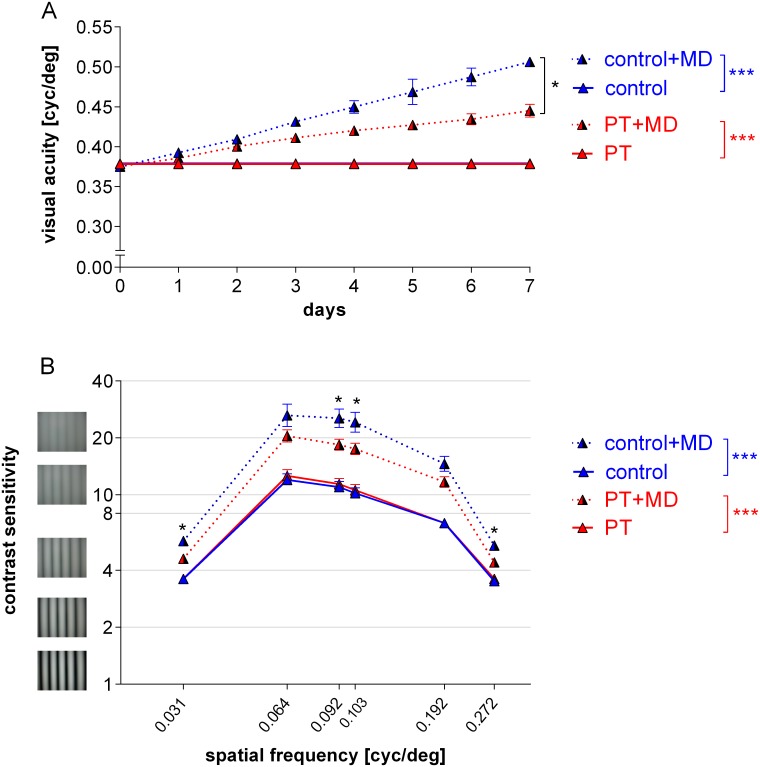
The M2-lesion severely impaired improvements of visual capabilities of the open eye after MD.Spatial frequency selectivity of the optokinetic response of the open eye in cycles per degree (cyc/deg) plotted against days (A) and contrast sensitivity at 6 different spatial frequencies (B) in control and PT-mice without and with MD (+MD). In both, control and PT-mice, values of the nondeprived (open) eye increased compared to mice without MD. However, the increase in PT-mice was only about 50% of the improvement of control mice.